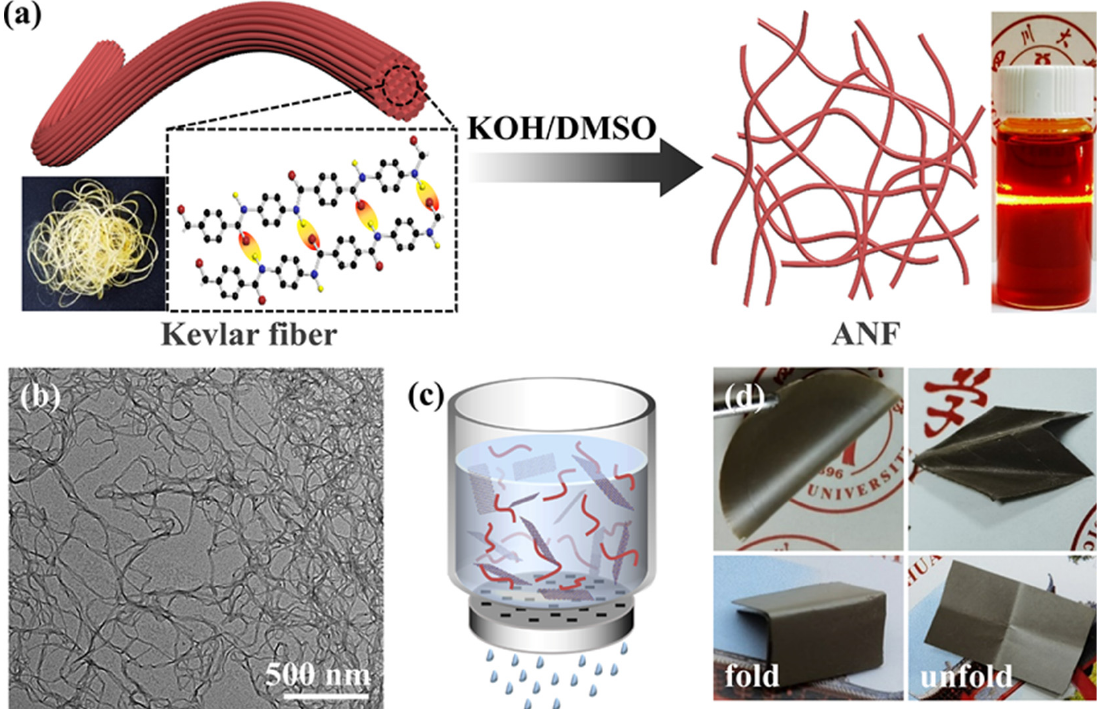
Figure 2. Fabrication of ANF and ANF/BNNS@Ag composite films. ( a ) Schematic process of the preparation of ANF by dissolving Kevlar ® 29 fibers in DMSO with the assistance of KOH. ( b ) TEM image of the ANF. ( c ) Schematic diagram of vacuum filter device for preparing thermally conductive composite films. ( d ) The photographs of mechanical flexibility of the ANF/BNNS@Ag thermally conductive composite film.